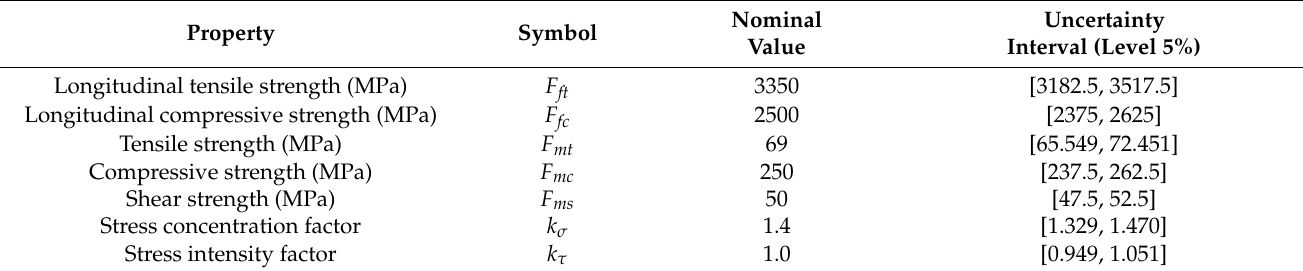
Table 3. Nominal values and uncertainty intervals of the strengths of the fibers and the matrix of the AS4/3501-6 composite ply. The data have been taken from [28].